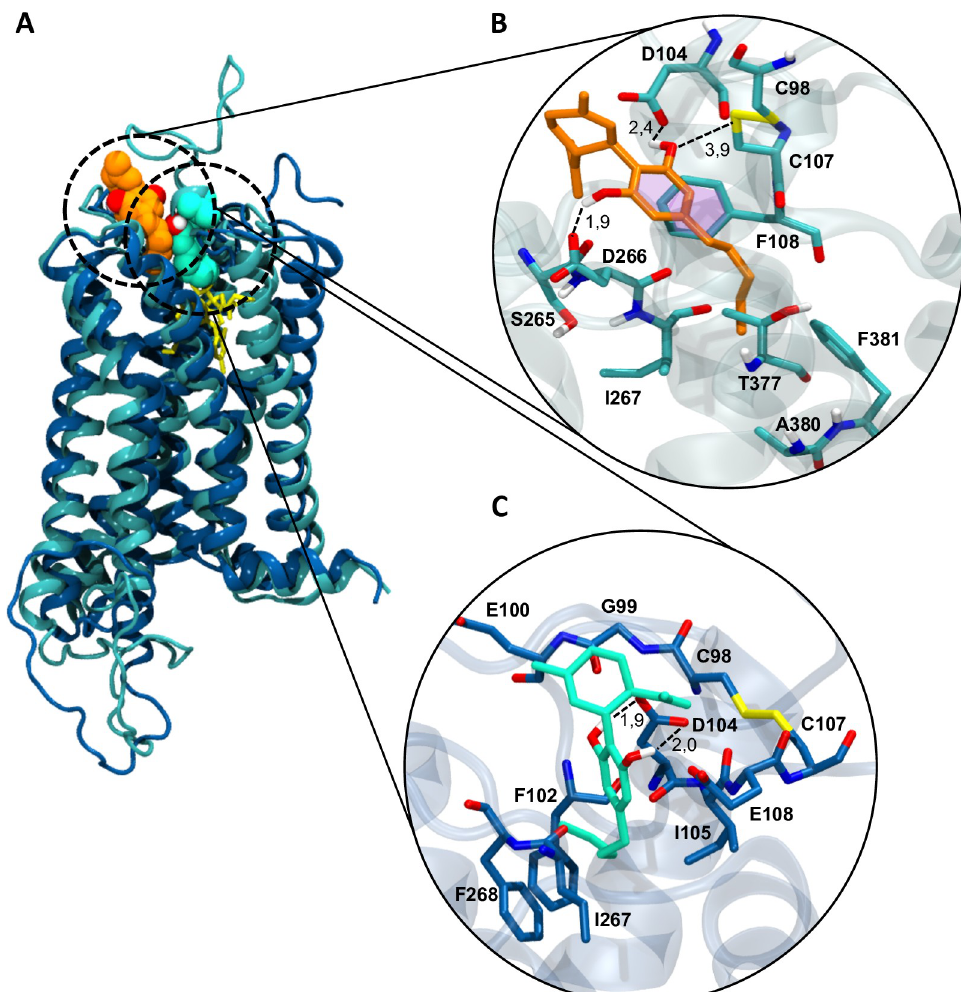
Fig 5. Docking conformations of CBD in the CB 1 R. (A) Superposition of the active (cyan) and inactive (blue) receptor conformation and vdW representation of CBD in orange and green respectively. The orthosteric ligands THC and rimonabant are shown in yellow sticks. (B) CBD (orange sticks) bound to the active receptor conformation. (C) CBD (green sticks) bound to the inactive receptor conformation. Nearby residues ( < 5 Å ) are shown, polar interactions are indicated with dotted lines, aromatic interactions are indicated by pink surfaces and distances are expressed in Å